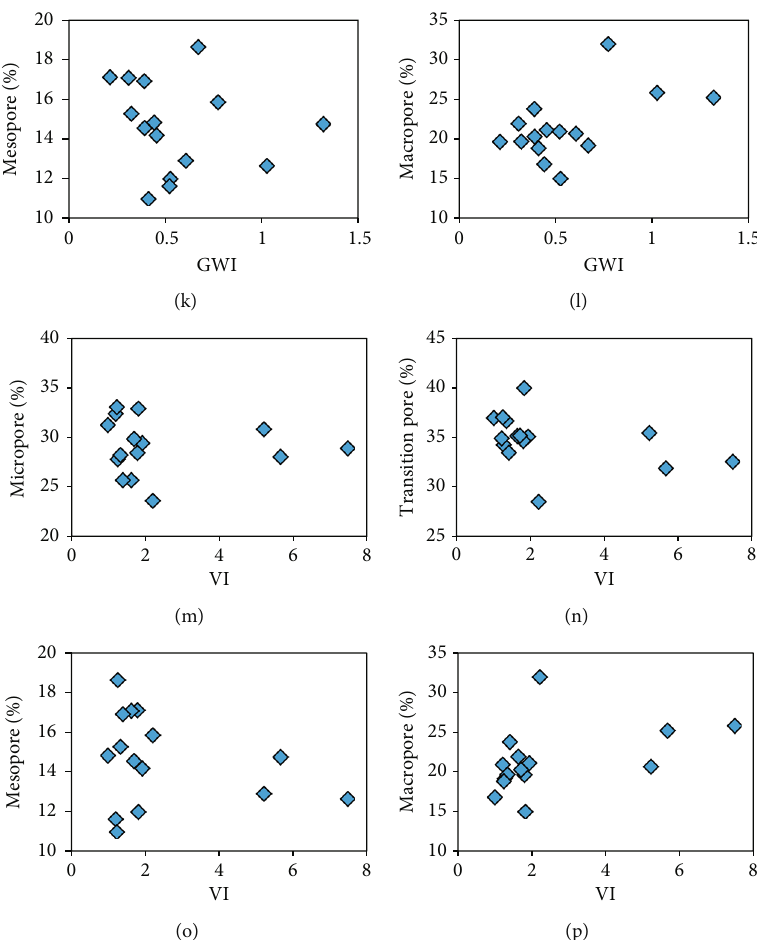
Figure 10: Relationships between the pore size and coal facies parameters. (a) Micropores ( < 10nm) versus TPI; (b) transition pores (10- 100nm) versus TPI; (c) mesopores (100-1000nm) versus TPI; (d) macropores ( > 1000 nm) versus TPI; (e) Micropores versus GI; (f) transition pores versus GI; (g) mesopores versus GI; (h) macropores versus GI; (i) micropores versus GWI; (j) transition pores versus GWI; (k) mesopores versus GWI; (l) macropores versus GWI; (m) micropores versus VI; (n) transition pores versus VI; (o) mesopores versus VI; (p) macropores versus VI.